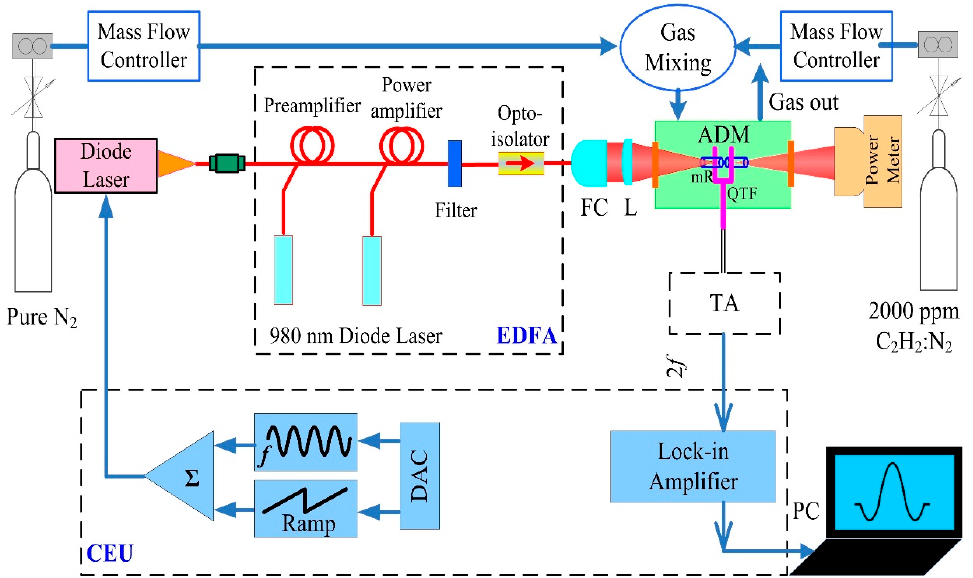
Figure 4. EDFA-based QEPAS sensor system.